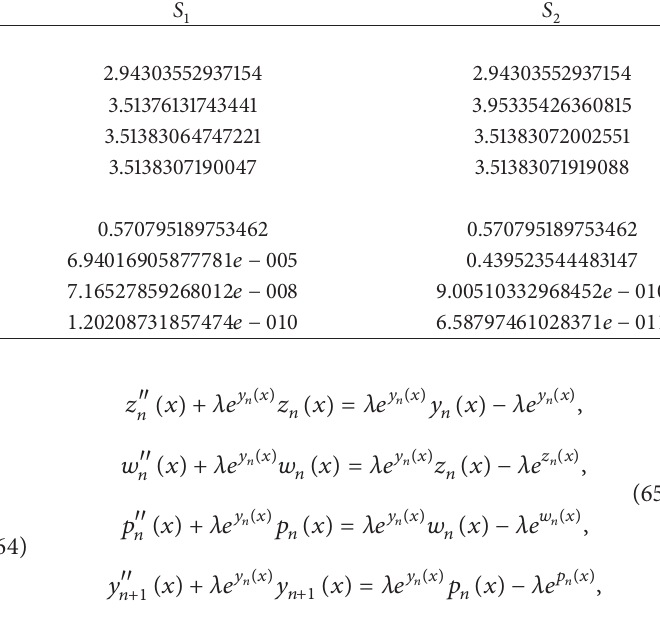
Table 3: Iterative convergence for different schemes for the critical value of 𝜆 𝑐 for Bratu problem, 𝑁 = 200 .